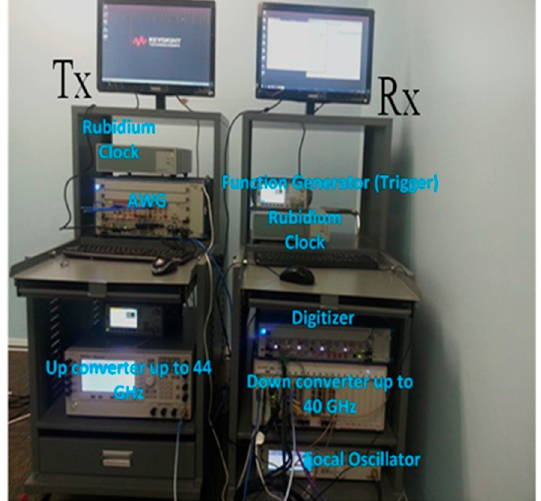
Figure 1. Measurement Equipment.